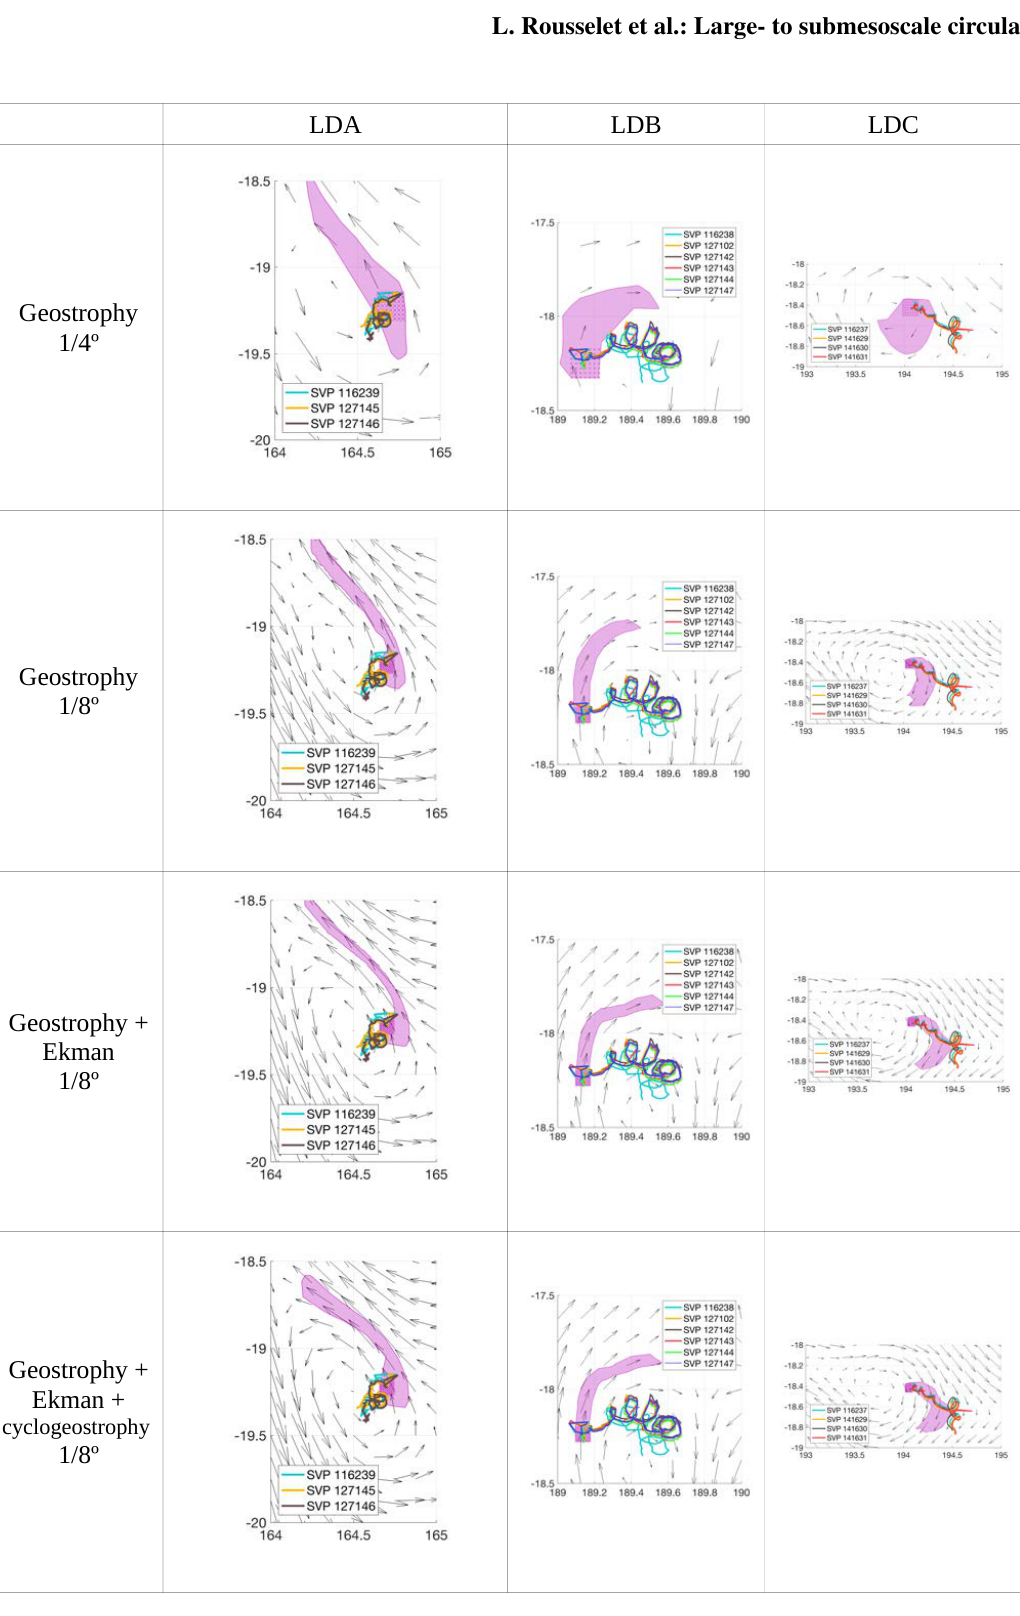
Figure 2. Trajectories of numerical particles computed with Ariane (purple patch) with each satellite products and in situ floats (colours) for 8 days after the starting date of each long-duration station. The surface velocity fields of the last day of particle integration (LDA: 4 March; LDB: 23 March; LDC: 31 March) are also shown with black